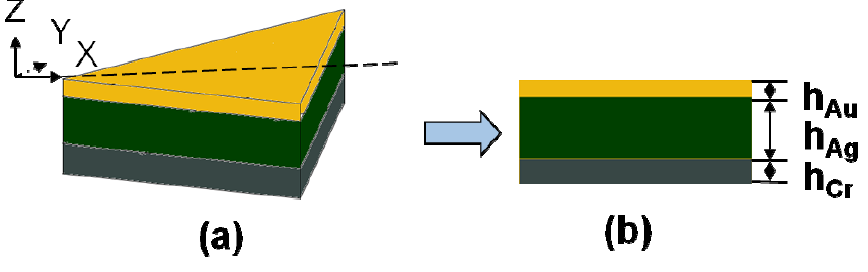
Figure 1. Schematic view of a single hybrid Au-Ag nanoparticle ( a ) In 3D view ( b ) Side cross-section